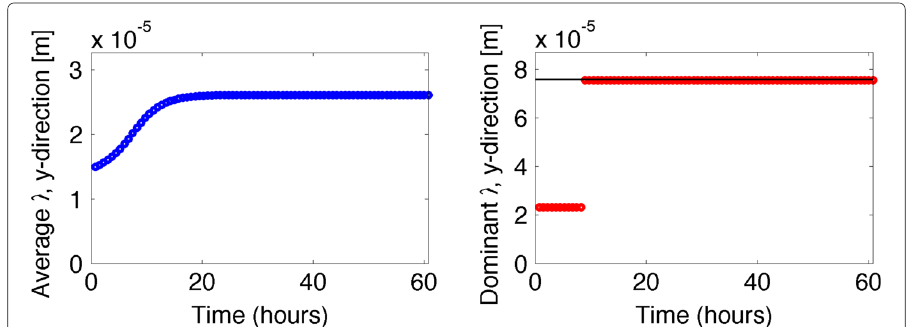
Fig. 4 Convergence of the averaged wavelength in the y-direction ( left ) to show changes in the distribution function over time. The dominant wavelength ( right ) shows the ripple wavelength that is most present in the morphology. Blackhorizontalline indicates analytical result